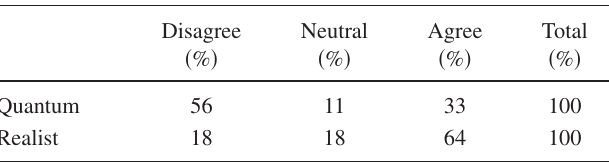
TABLE VIII. Combined post-responses to QA No. 16 (cid:1) col- umns (cid:2) , grouped according to student responses to the quantum wave interference essay question (cid:1) rows (cid:2) .